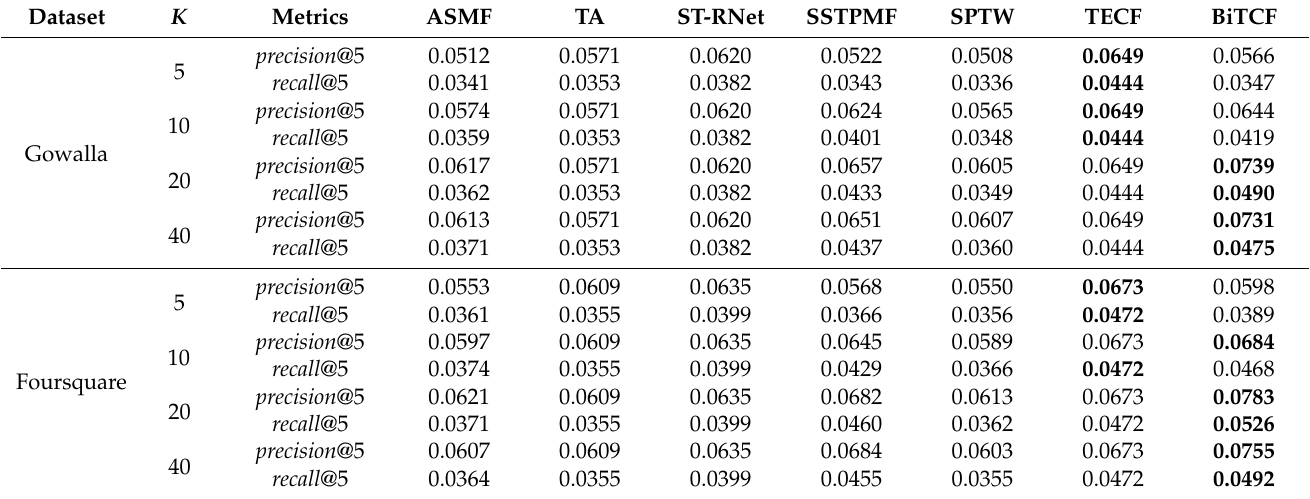
Table 3. Comparisons on the performance of the models with top-5 POIs in different